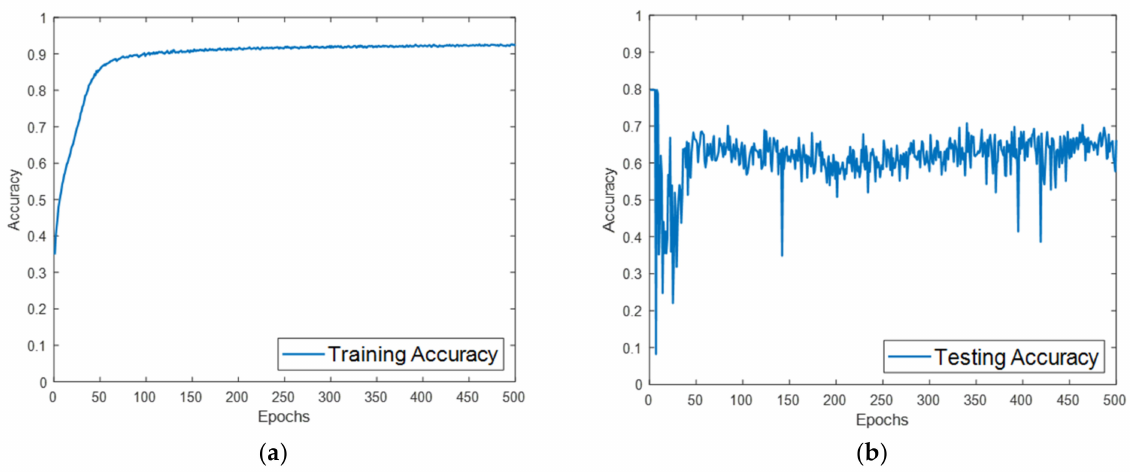
Figure 4. Performance of ResNet trained with original database: ( a ) training accuracy curve; ( b ) testing accuracy